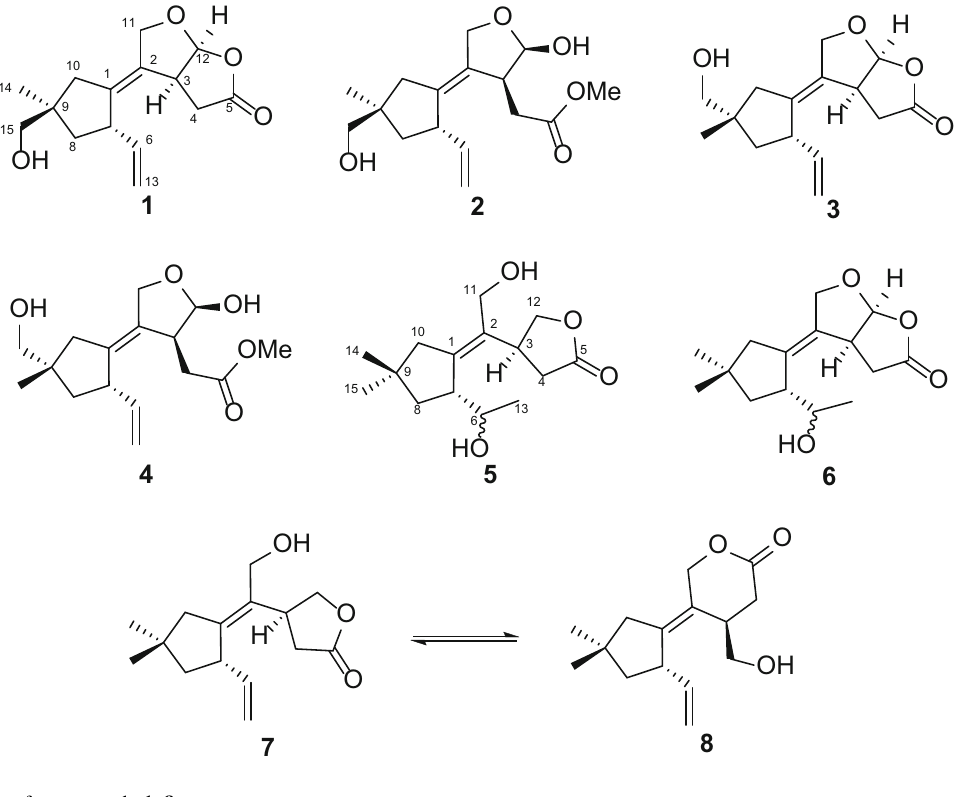
Fig. 1 Structures of compounds 1 –